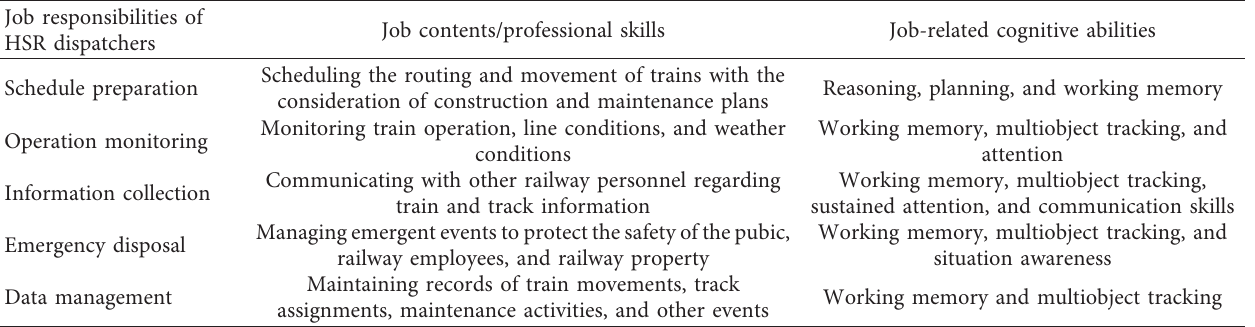
Table 1: The HSR dispatcher’s job responsibilities and the necessary cognitive